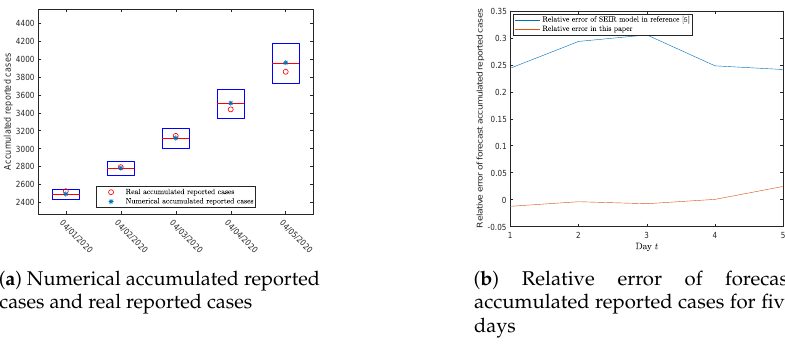
Figure 4. The numerical cases for accumulated reported cases for five